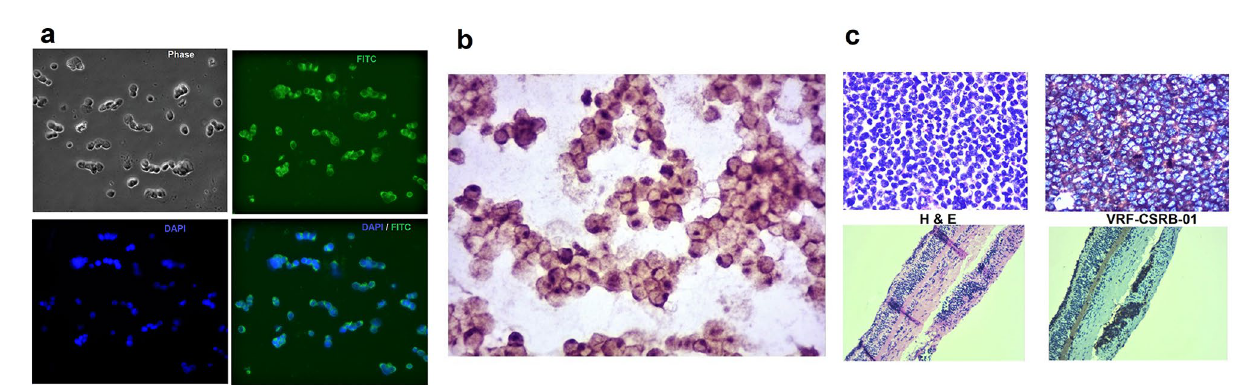
Figure 5. The binding ability of VRF-CSRB-01 to Weri-RB1 by IFC, ICC and RB tumour sections by IHC. ( a ) Microscopy results showed membrane positivity of VRF-CSRB01 by the fluorescence imaging in Weri-RB1. ( b ) ICC of Weri-RB1 cells incubated with biotin labelled VRF-CSRB-01 and analysed by light microscope. ( c ) H and E staining and () IHC with biotin labelled VRF-CSRB-01 of primary retinoblastoma tumours and retina